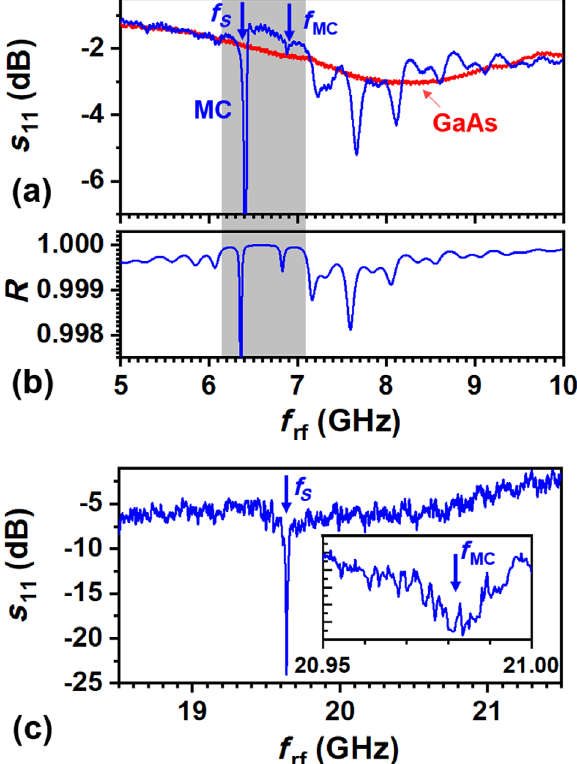
FIG. 2. (a) Electrical response of a BAWR on sample A at 300 K. The red curve shows the s 11 scattering parameter for a BAWR on a bare GaAs substrate, while the blue one gives the response of a device on a MC (sample A ). Both devices have nominally identical ZnO thickness of 260 nm. The gray-shaded area designates the spectral range of acoustic stop band created by the AODBR displayed in Fig. 1(a). The two modes within the ¼ stop band correspond to the MC acoustic mode with f MC 6 . 9 GHz and the surface mode f ¼ 6 . 4 GHz confined between S the BAWR surface and the upper AODBR. (b) Simulated acoustic reflectivity of the MC with a BAWR device on its surface. (c) Electrical response of a BAWR on sample B measured at 10 K, as given by the s 11 scattering parameter recorded as a function of the frequency. The curves are acquired using a BAWR with circular (rather than ring-shaped) contacts with a diameter of 20 μ